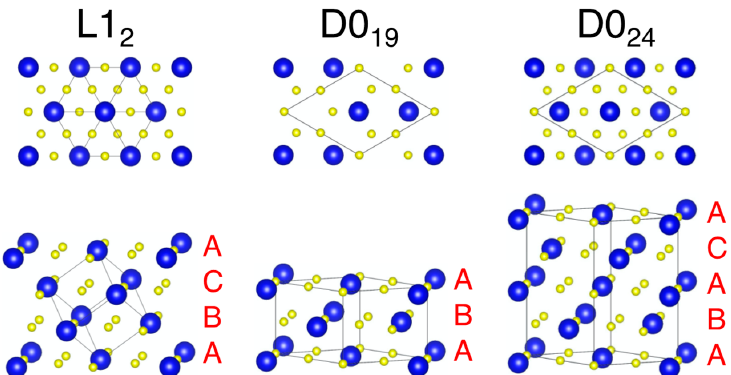
Figure 1. Atomic structures of L1 2 ( γʹ ), D0 19 ( χ ), and D0 24 ( η ) phases, shown for the fully relaxed Ni 3 Ti. The upper panel shows cubic (111) and hexagonal (0001) projections. The lower panel compares stacking of the 2D layers. Ti (Al) atoms are dark blue; Ni atoms are small yellow. In the Ni 3 (Al 1 − x Ti x ) 1 ternary system the terminal binary L1 2 Ni 3 Al and D0 24 Ni 3 Ti structures differ. We investigate the phase stability of Ni 3 (Al 1 − x Ti x ) 1 with a homogeneous atomic disorder on the (Al 1 − x Ti x ) sublattice, consider energy gain due to the atomic ordering, and construct the ground-state hull. We predict the existence of the fully ordered structures at intermediate compositions—in addition to the known binary L1 2 Ni 3 Al and D0 24 Ni 3 Ti structures. A subset of the predicted ground-state structures is shown in Figure 2. The computed energies are plotted in Figure 3.